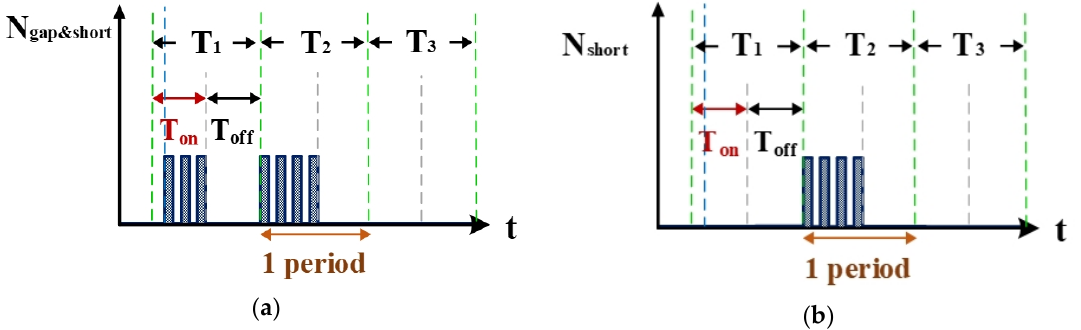
Figure 8. Counter waveforms of ( a ) signal I gap and ( b ) short circuits.